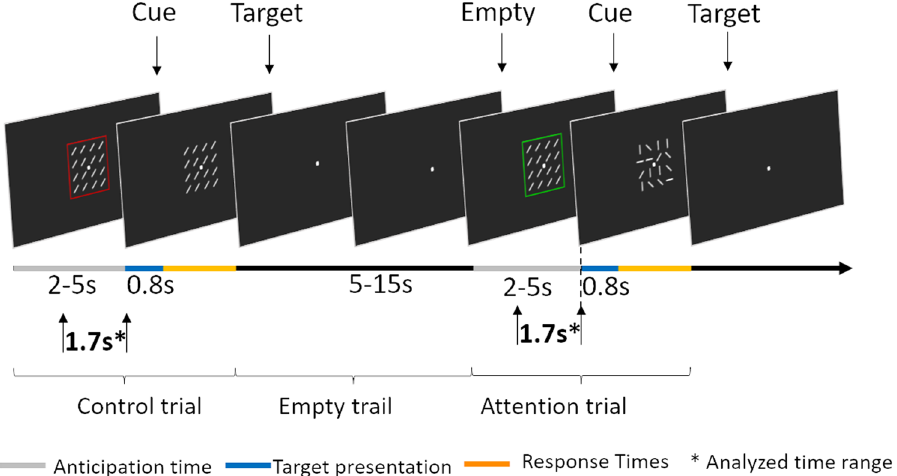
Figure 9. Visual search experiment set-up. Participants were presented with the control trials, attention trials and empty trials. During control trials, participants were asked to indicate on the target matrix the direction of the identically oriented bars. In the attention trials, participants were expected to confirm whether the bar with orientation specified on the cue matrix was present among differently oriented bars on the target. Empty trials were devoid of matrix stimulus. Cue presentation (anticipation time) lasted 2–5 s and ended with presentation of the target matrix for 800 ms. The data used for analyses were extracted from the 500 ms sliding windows (300 ms overlap) moving over 1700 ms preceding the onset of target matrices (expectation windows) marked by arrows and